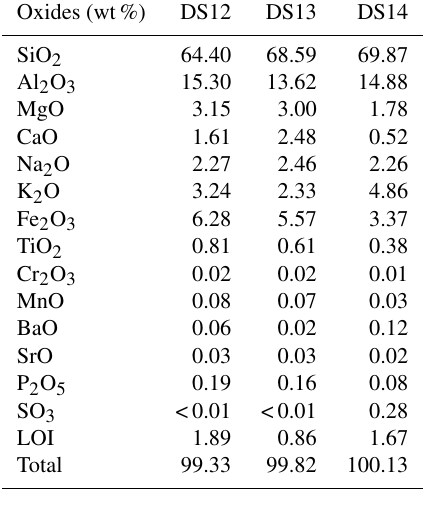
Figure 3. Representative complex impedance spectra for run DS12 gneiss under conditions of 1.5GPa and 623–1073